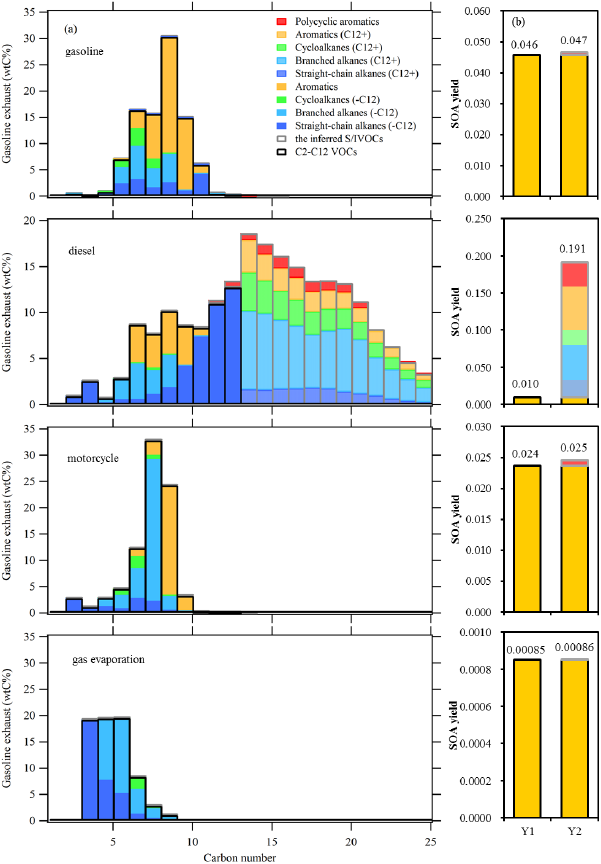
Figure 5. (a) Distributions of mass by chemical class in carbon number of different vehicle exhausts and evaporative emissions; (b) calculated SOA yields based on C2–C12 VOCs measured in this study (Y1) and C2–C12 VOCs plus the inferred S/IVOC species (Y2). The inferred S/IVOC species are shown in light-colored